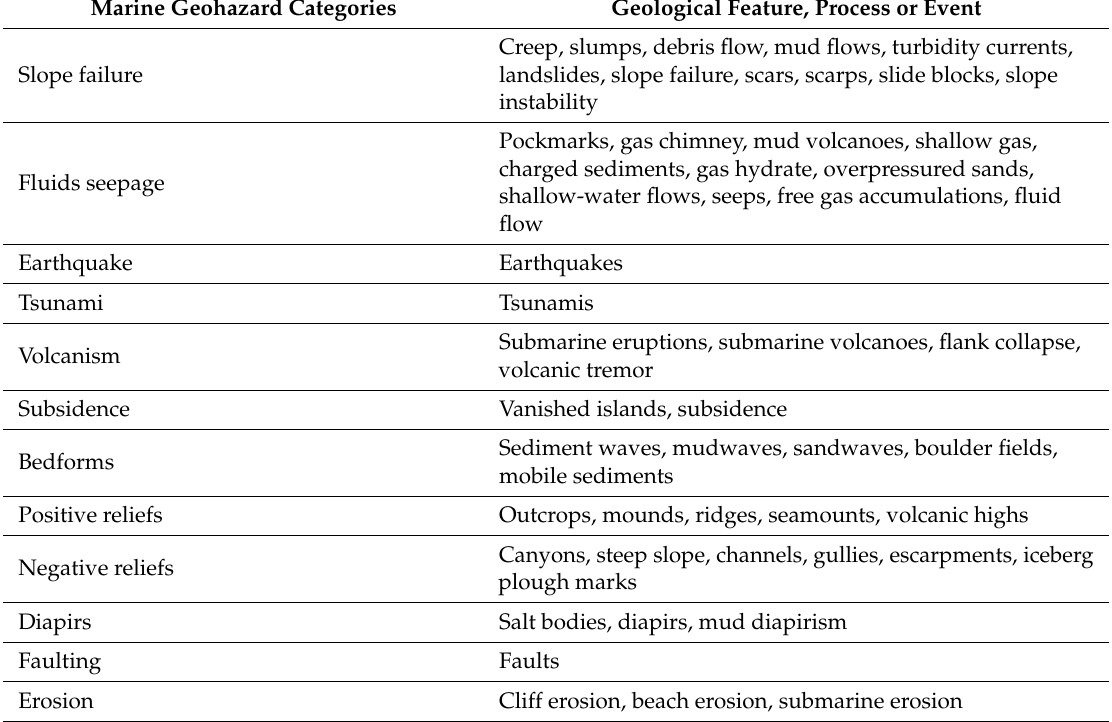
Table 1. Categories of geohazards defined after the grouping of features, process, and related events with a similar nature.